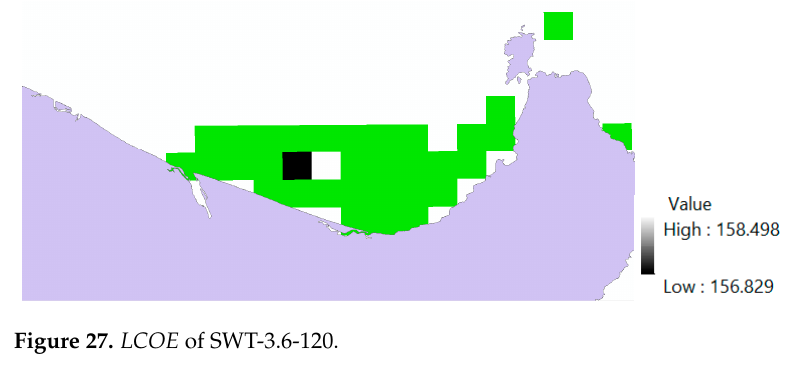
Figure 27. LCOE of SWT-3.6-120.